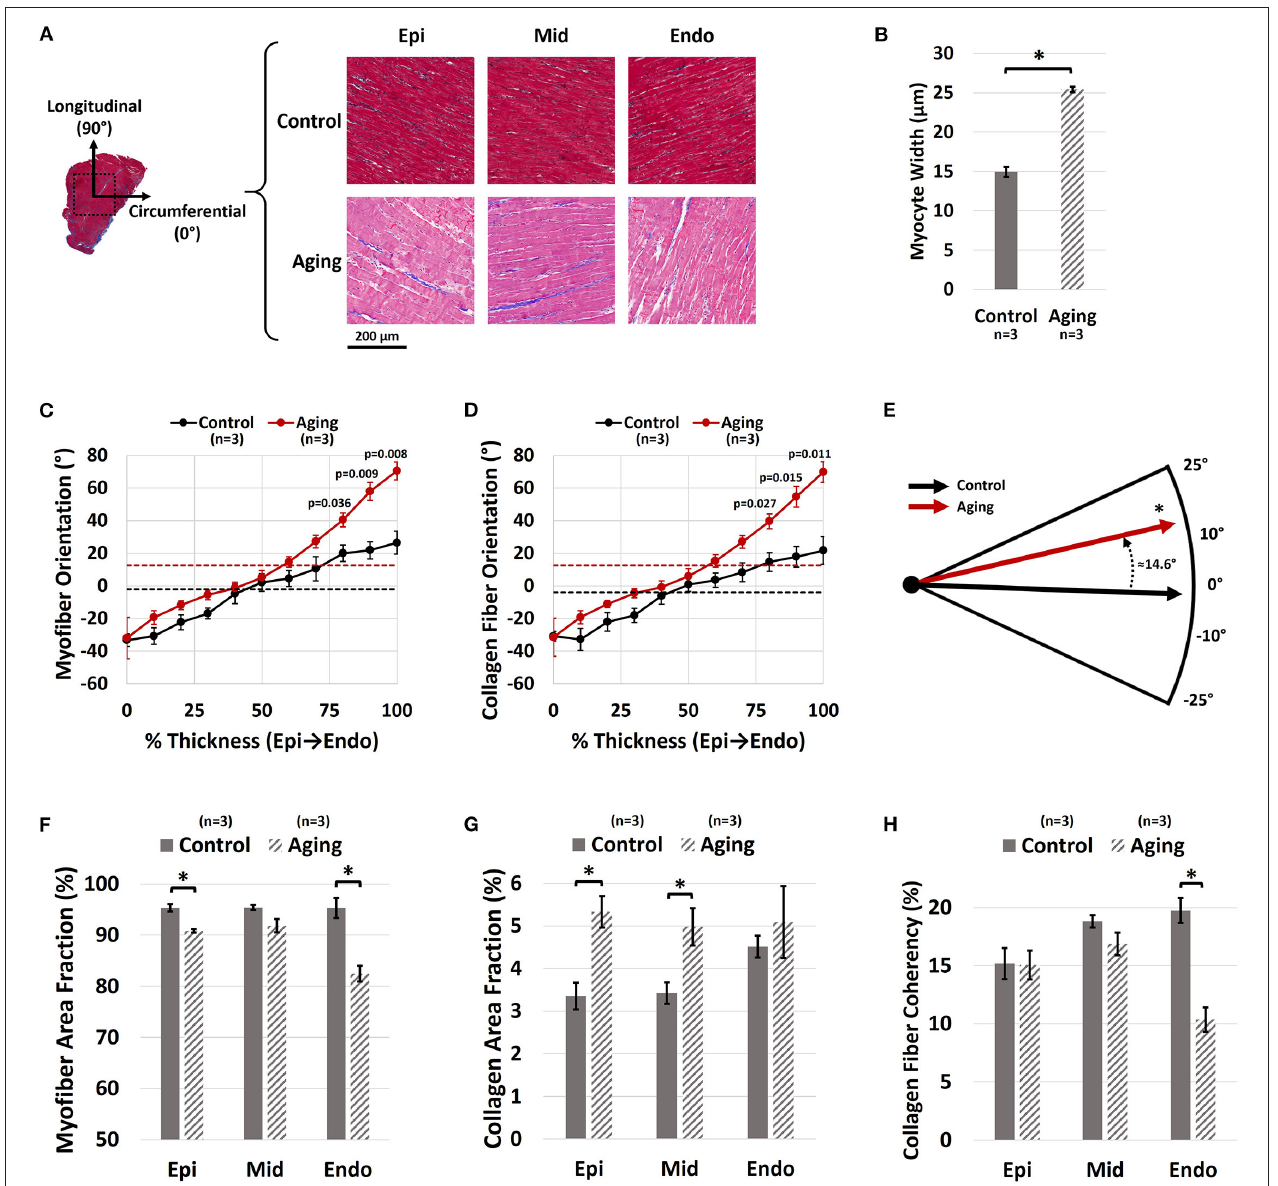
FIGURE 4 | Histological analysis of the effects of healthy aging on RV structure. (A) Representative transmural histological sections of the RVFW (Red/Pink: Myofiber, Blue: Collagen) and effects of aging on (B) Cardiomyocyte hypertrophy (myocyte width), (C) Transmural myofiber orientations, (D) Transmural collagen fiber orientations, (E) Dominant myofiber orientations, (F) Transmural myofiber content (area fraction), (G) Transmural collagen content (area fraction), and (H) Transmural collagen fiber coherency. Healthy aging results in cardiomyocyte hypertrophy, in addition to reorientation of sub-endocardial collagen and myofibers toward the longitudinal direction. This is accompanied by cardiomyocyte loss, RVFW fibrosis, and decreased collagen fiber coherency. Error bars represent standard error of the mean (SEM). *Indicates p < 0.05. RV, Right ventricle; RVFW, Right ventricular free wall; Epi, Epicardium; Mid, Mid-ventricular region; Endo,